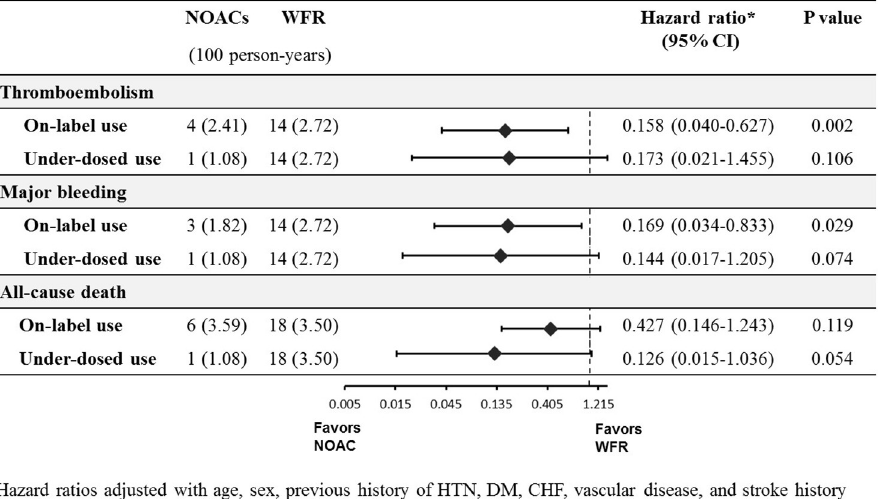
Fig 4. Clinical outcomes according to dose of NOACs. Hazard ratio adjusted with age, sex, previous history of hypertension, diabetes mellitus, congestive heart failure, vascular disease and stroke history. NOAC, non-vitamin K antagonist oral anticoagulants; WFR,